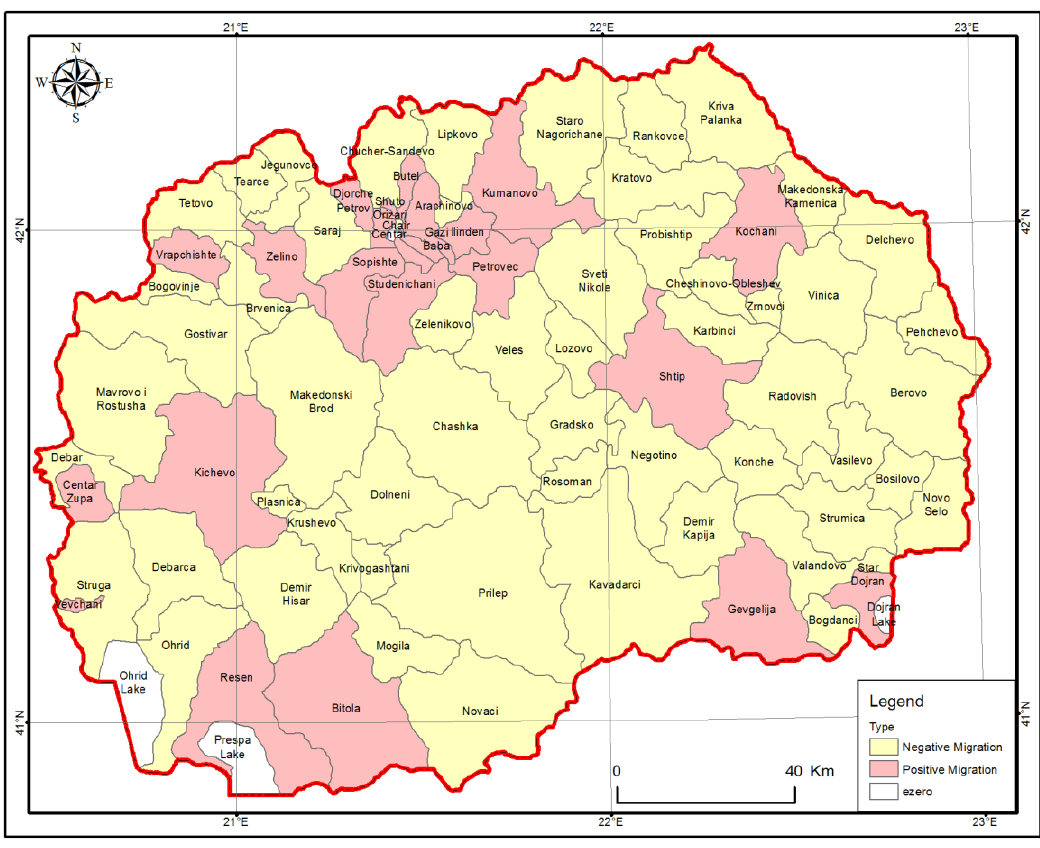
Fig. 8. Values of net migration by municipalities, for the period 2002-2013 (calculated by the authors, according to SSORM, map author, Gorin)